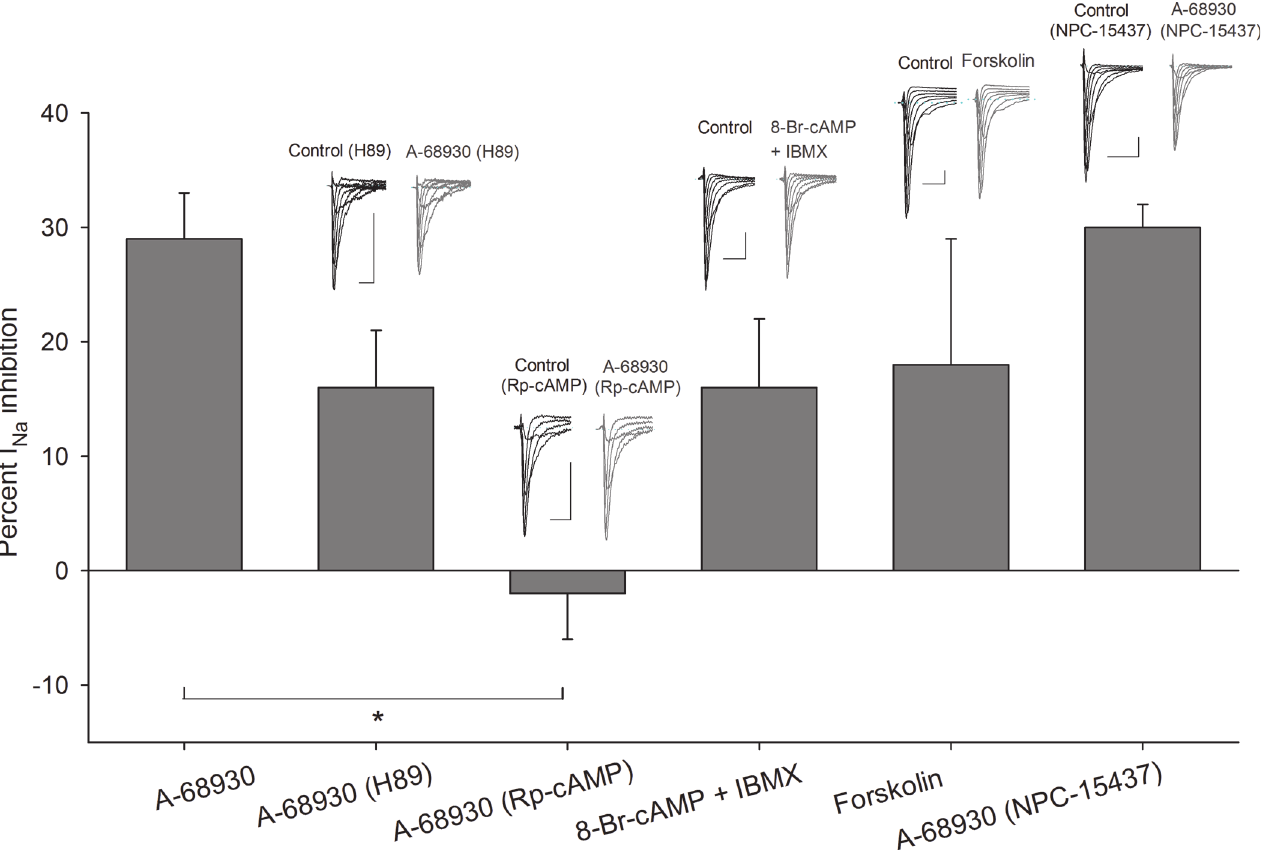
Fig 5. Transducer mechanisms activated by D1-like receptors. Bars show the effect of A-68930 in control condition in comparison with its action while other drugs were used. The use of H89 in the intracellular solution decreased the inhibitory effect of A-68930 from 29 ± 4% to 16 ± 5% at − 10 mV ( P = 0.08). When cells were preincubated with 50 μ M Rp-cAMP, A-68930 effect was completely blocked ( P < 0.001). Coapplication of 8-Br-cAMP and IBMX mixture caused a decrease in the I Na current which mimicked the effect of A-68930 ( P = 0.114). Forskolin also mimicked the effect of D1-like agonist decreasing the I Na 18 ± 11% ( P = 0.27). The NPC-15437 in the intracellular solution did not significantly modify the A-68930 effect ( P = 0.92). Insets above bars show typical recordings of the I Na under control conditions and after drug application. Calibration bars are 2 ms and 0.5 nA for all recordings.